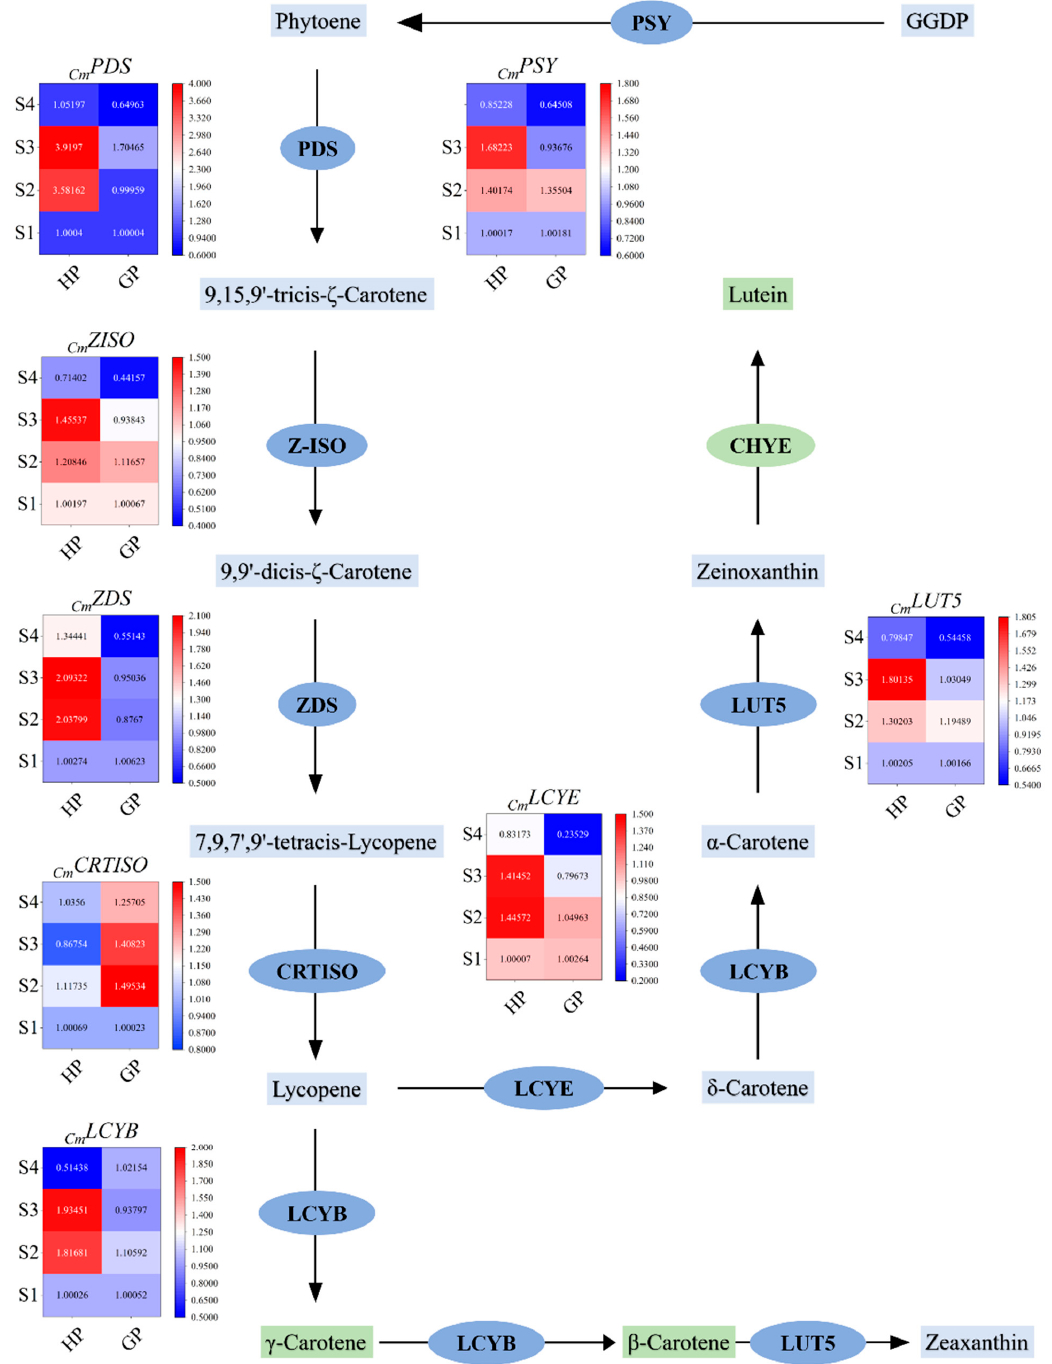
Figure 3. Carotenoid biosynthesis pathways and related gene expression levels during early fruit development. Values are showed as the means ± SD (n = 3). GGDP, geranylgeranyl diphosphate; PSY , phytoene synthetase; PDS , phytoene desaturase; Z-ISO , ζ -carotene isomerase; ZDS , ζ -carotene desaturase; CRTISO , carotenoid isomerase; LCYE , lycopene ε -cyclase; LUT5 , β -ring hydroxylase; LCYB , lycopene β